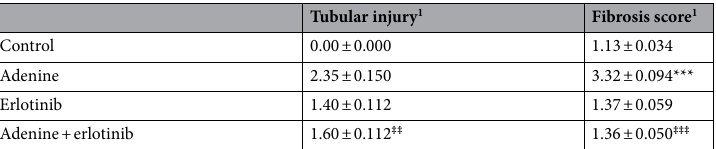
Table 1. Effect of erlotinib (80 mg/kg) on renal tubular injury and fibrosis score in adenine induced renal injury in mice. 1 Scores were calculated /20 fields. *** P < 0.001 compared to control group. ‡‡ , ‡‡‡ P < 0.01, 0.001respectively compared to adenine group.